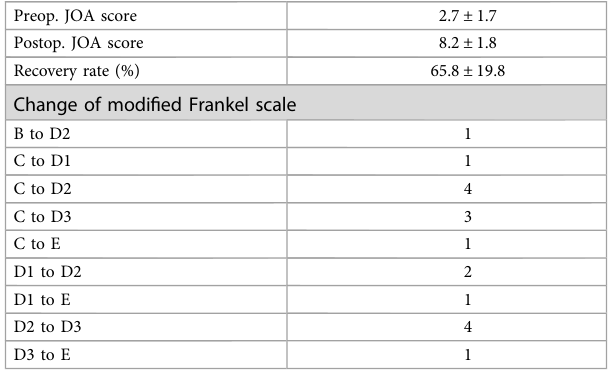
TABLE 3 Pre- and postoperative neurological evaluation of the